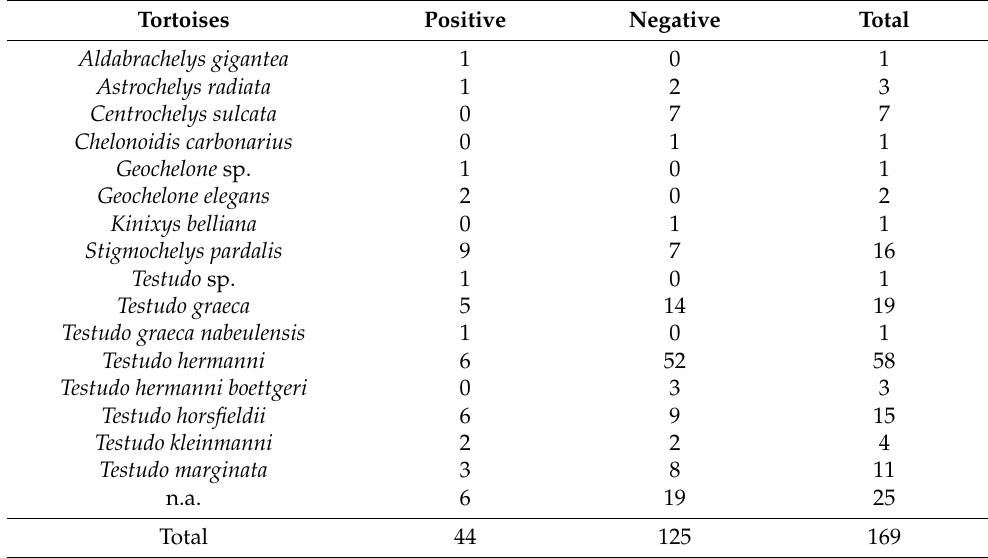
Table 1. Species of tortoise tested for Mycoplasmopsis agassizii by PCR. Tortoises Positive Negative